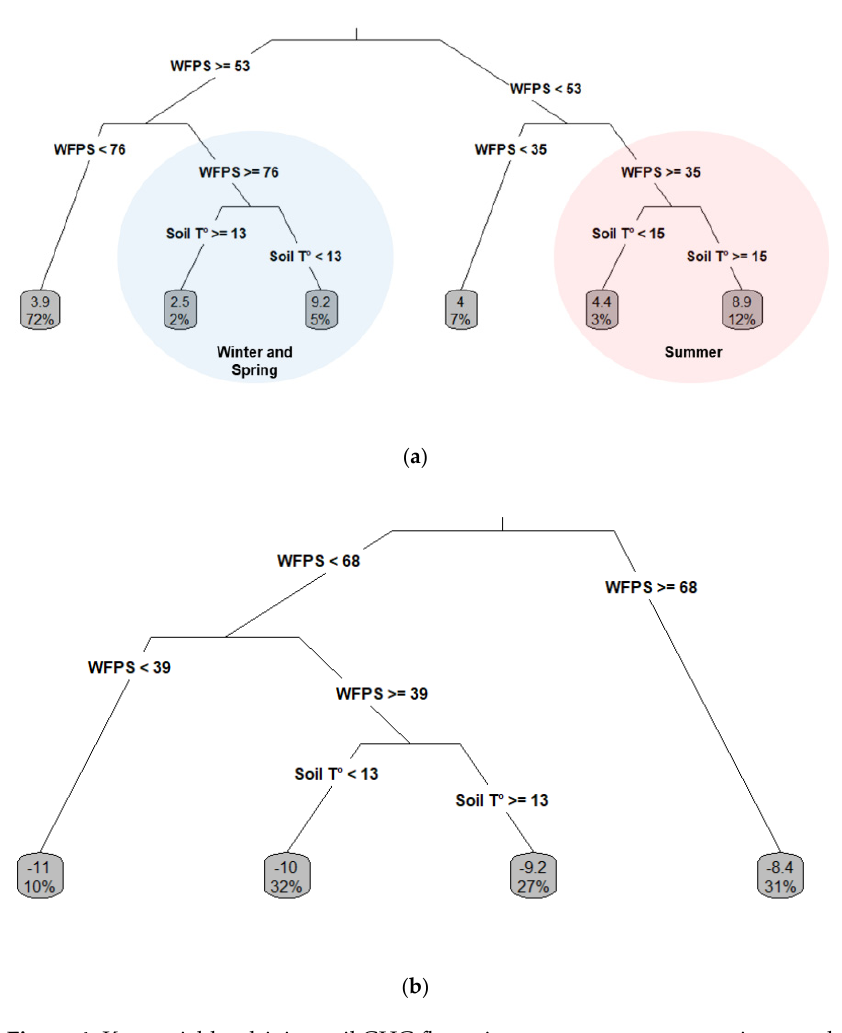
Figure 4. Key variables driving soil GHG fluxes in a temperate pasture, using tree decision